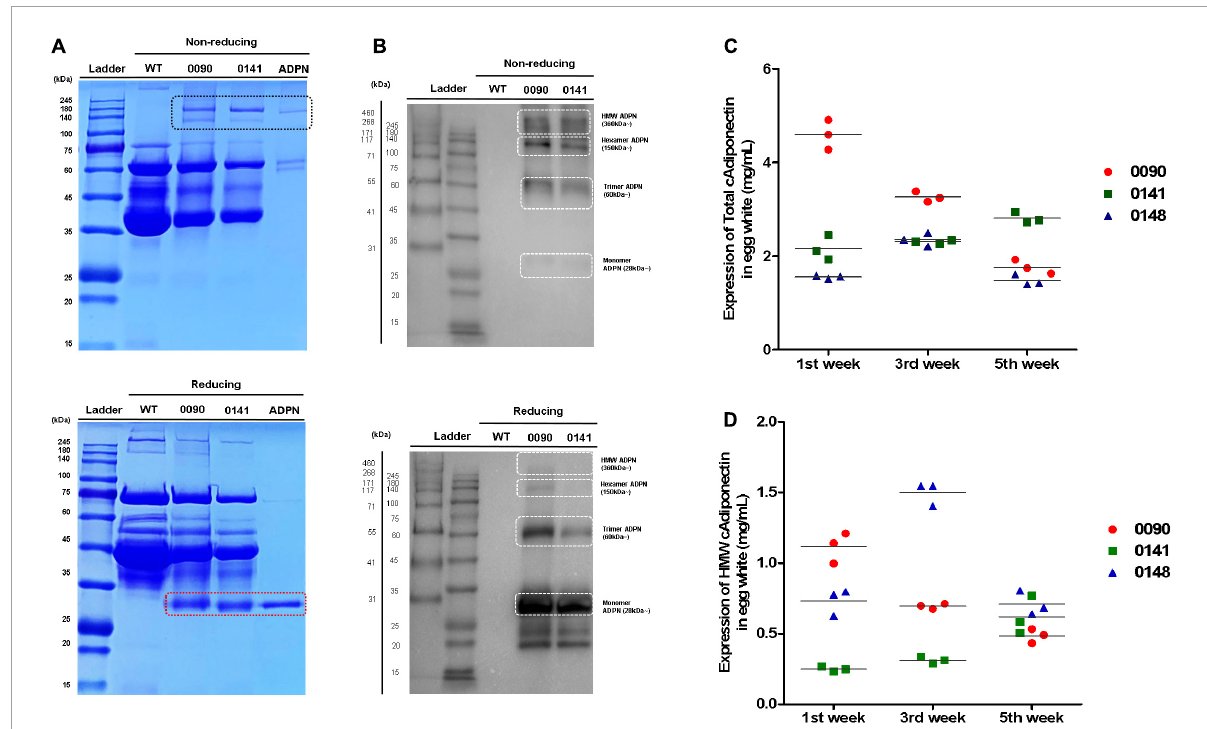
FIGURE3 Measurement of total ADPN and HMW ADPN contents in G 1 OVA ADPN KI hen’s eggs. (A) Detection of ADPN protein in OVA ADPN KI chicken egg white (W0090 and W0141, respectively) by SDS-PAGE under non-reducing and reducing conditions. The black box indicates multimeric adiponectin in non-reducing state. Red box indicate monomer size of ADPN. (B) Expression analysis of ADPN protein of OVA ADPN KI chicken egg white by western blotting under non-reducing and reducing conditions. White boxes indicate monomer (approximately 28 kDa), trimer (approximately 60 kDa), hexamer (approximately 150 kDa), and high molecular weight form (360 kDa ∼ ), respectively. (C) Analysis of total ADPN protein expression level from OVA ADPN KI chicken egg (W0090, W0141, and W0148) by ELISA at 1st week, 3rd week, and 5th-week consecutively. (D) Analysis of HMW ADPN protein expression level from OVA ADPN KI chicken egg (W0090, W0141, and W0148) by ELISA at 1st week, 3rd week, and 5th-week consecutively ( n = 3, each hen).